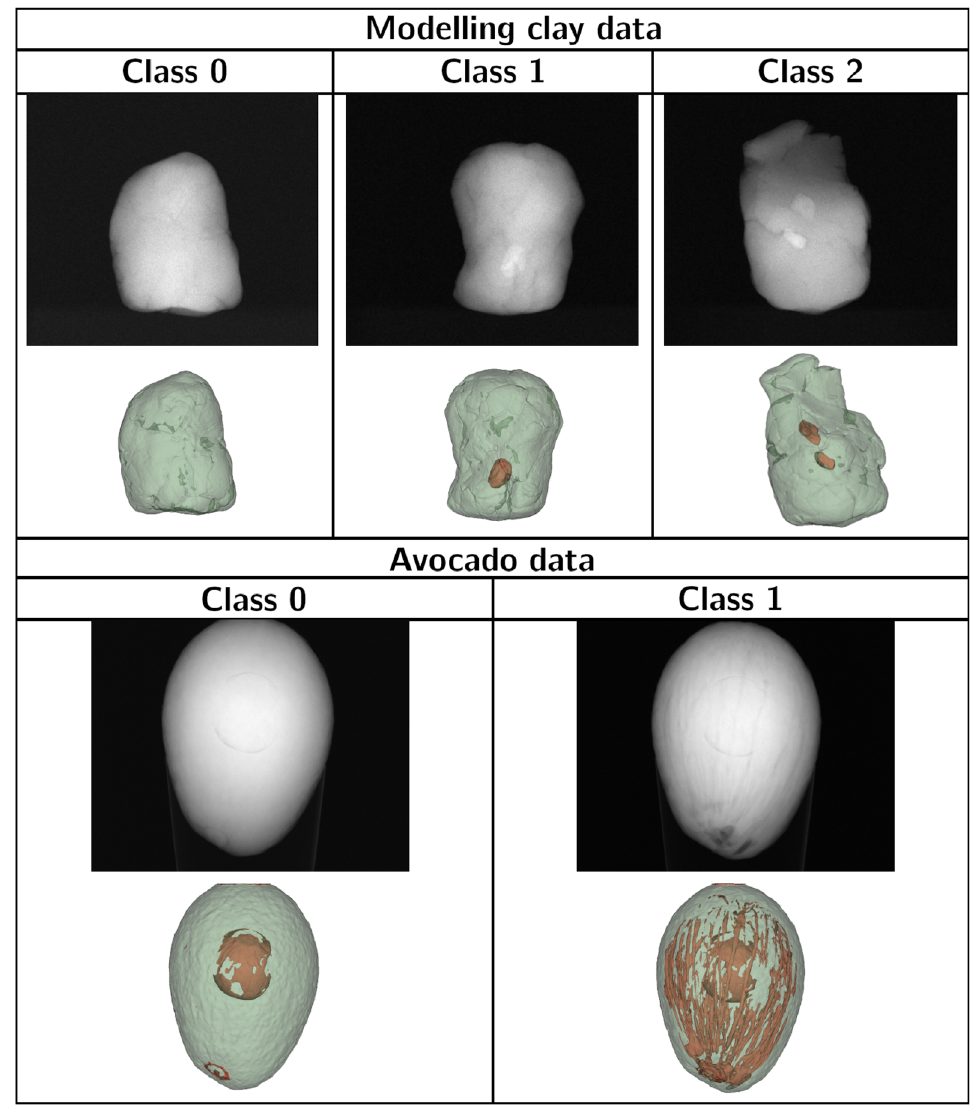
Figure 3. Examples of objects from differenct classes for two case studies. The first row corresponds to input X-ray images, and the second row shows visualization of the volume based on the segmentation (base object is colored green, foreign